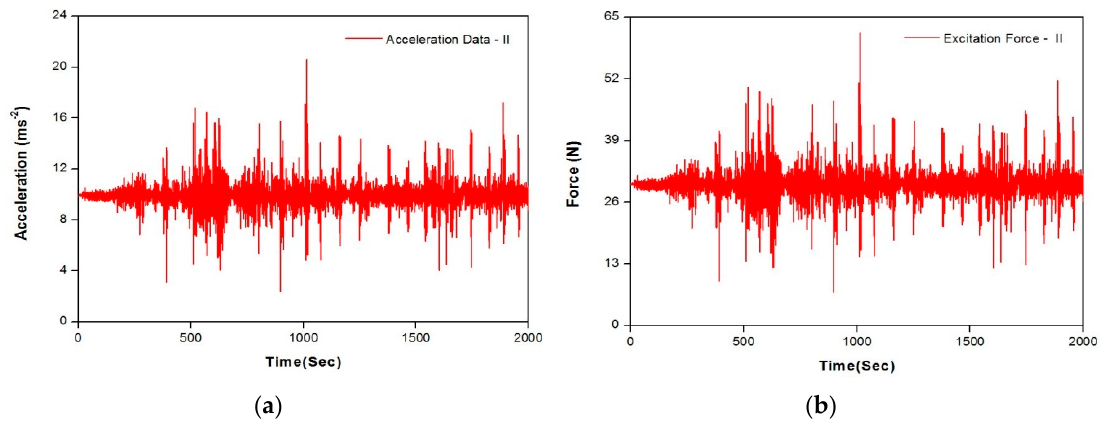
Figure 8. Input data for case II: ( a ) acceleration data; ( b ) excitation force.